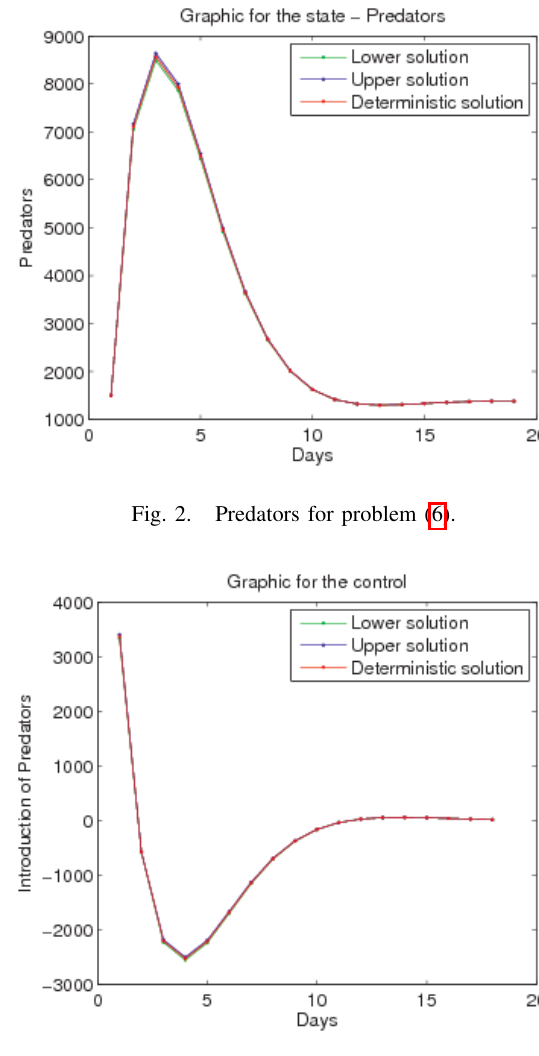
Fig. 3. Introduction of predators for problem